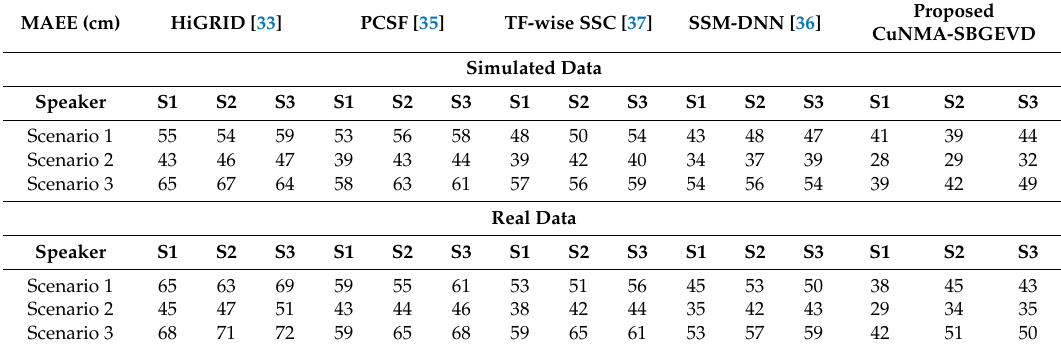
Table 3. The MAEE comparison between the proposed CuNMA-SBGEVD method and HiGRID, PCSF, TF-wise SSC, and SSM-DNN algorithms in reverberant, noisy, and noisy-reverberant scenarios on real and simulated data for 3 simultaneous speakers.